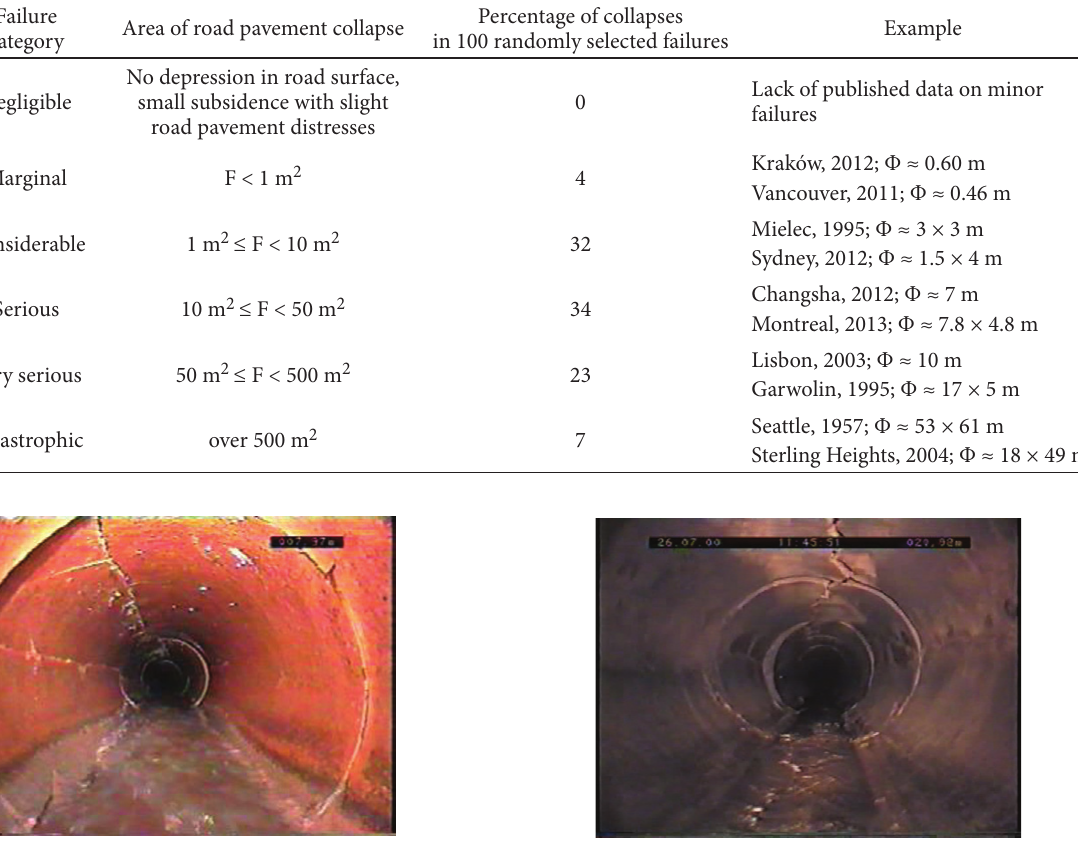
Fig. 3. Longitudinal cracks Fig. 4. Vertical deformation of a cracked pipe